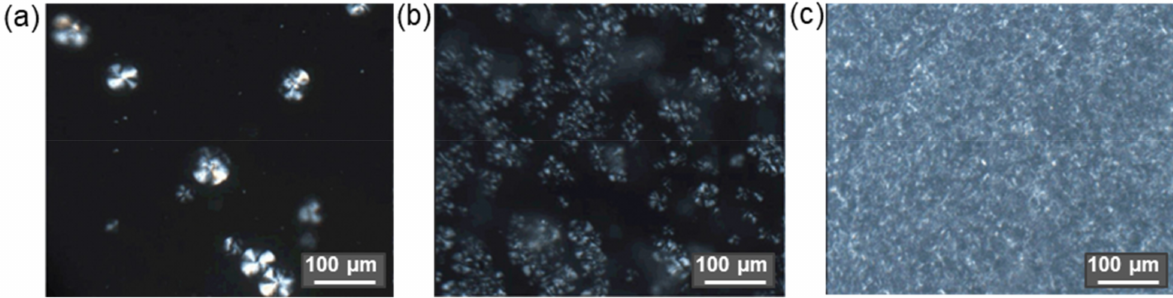
Figure 19. Polarized optical microscopy of PLLA crystallization at 120 ◦ C after heating to 185 ◦ C and hold for 4 min: PLLA ( a ), PLLA with 10 wt% CNC-g-PLLA ( b ) and PLLA with 10 wt% CNC-g-PDLA ( c ) (reproduced from [201] with permission of